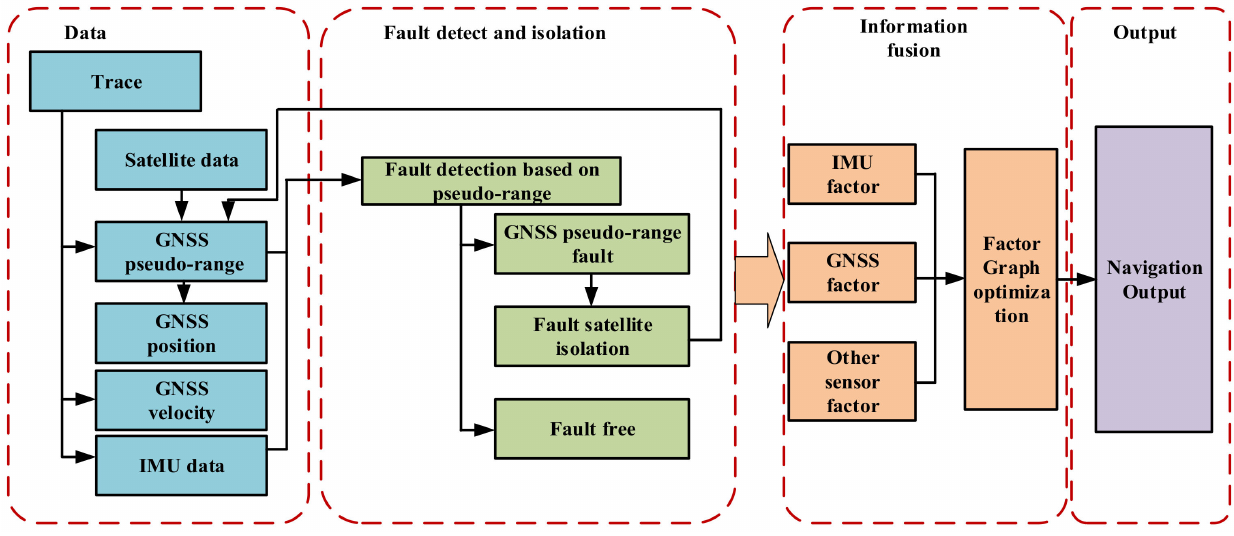
Figure 1. Scheme of integrity detection of integrated